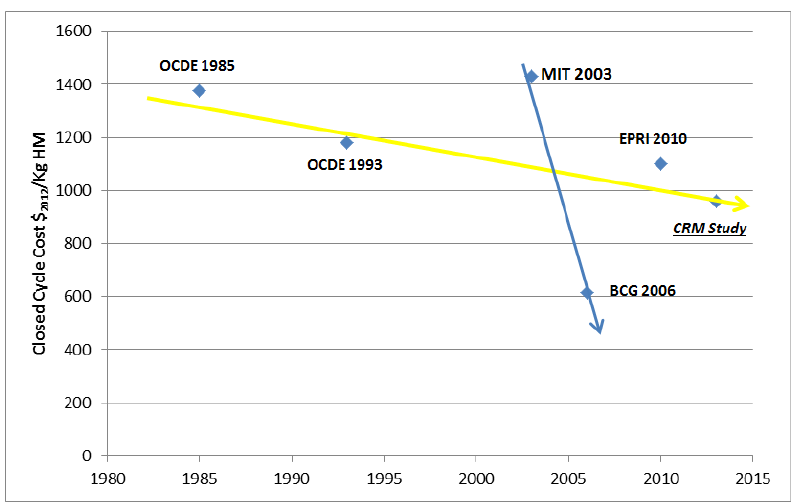
Figure 2. Trend analysis of the cost evolution in the closed